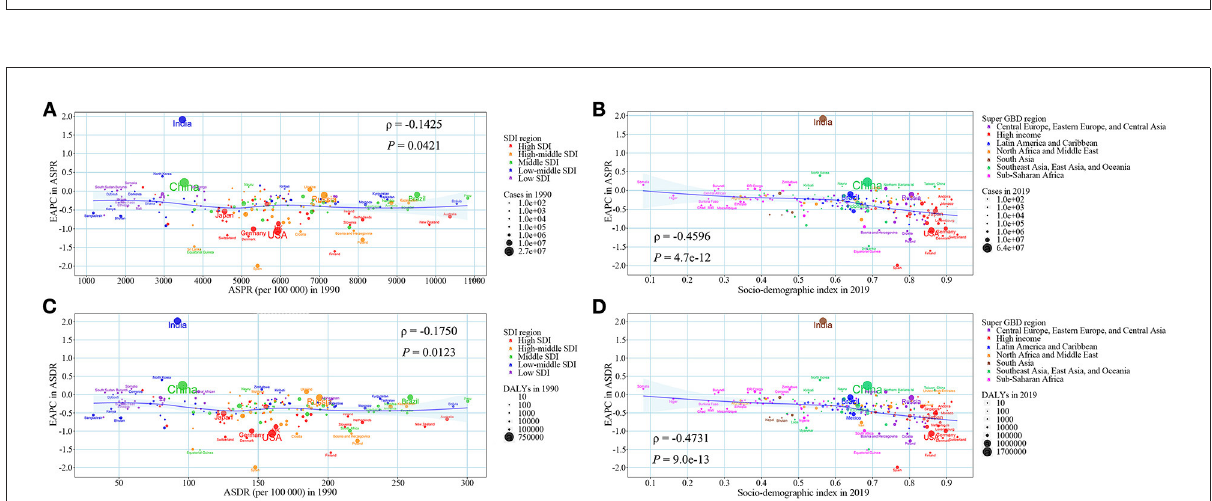
FIGURE4 The association between ASRs in 1990, SDI in 2019, and the EAPC of ASRs from 1990 to 2019. (A) ASPR in 1990 and the EAPC of ASPR from 1990 to 2019; (B) SDI in 2019 and the EAPC of ASPR from 1990 to 2019; (C) ASDR in 1990 and the EAPC of ASDR from 1990 to 2019; (D) SDI in 2019 and the EAPC of ASDR from 1990 to 2019. The blue line was an adaptive association fitted with adaptive Loess regression based on all data points. EAPC, estimated annual percentage change; SDI, socio-demographic index; ASDR, age-standardized DALY rate; DALY, disability-adjusted life year; ASPR, age-standardized prevalence rate; ASRs, age-standardized